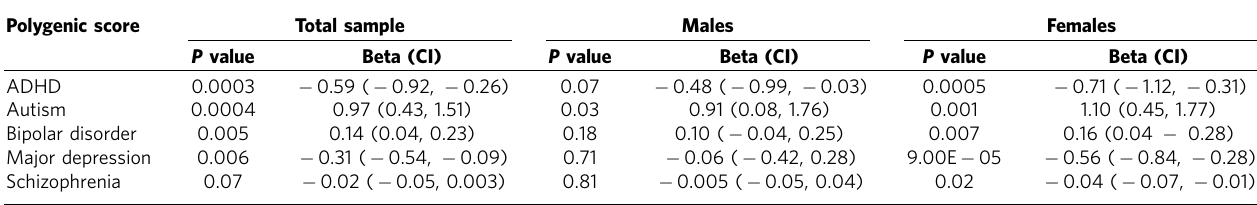
Table 3 | Association between polygenic risk scores and age at first